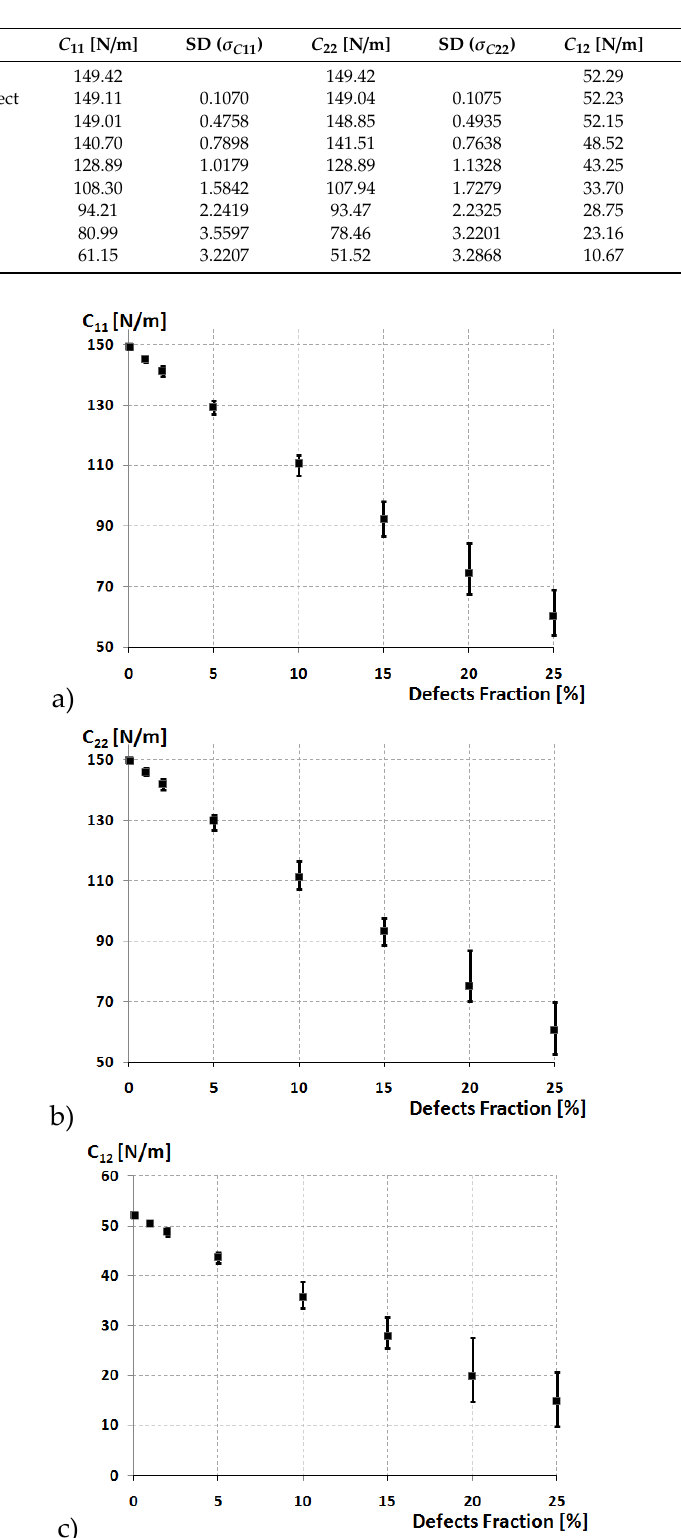
Figure 4. The elastic constants of MoS 2 as a function of the defect fraction: ( a ) C 11 , ( b ) C 22 , ( c ) C 12.